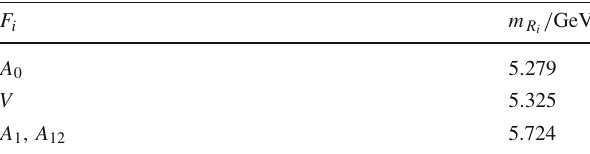
Table 4 Mass terms required for the evaluation of the different ¯ B → ρ form factors as given in Ref.